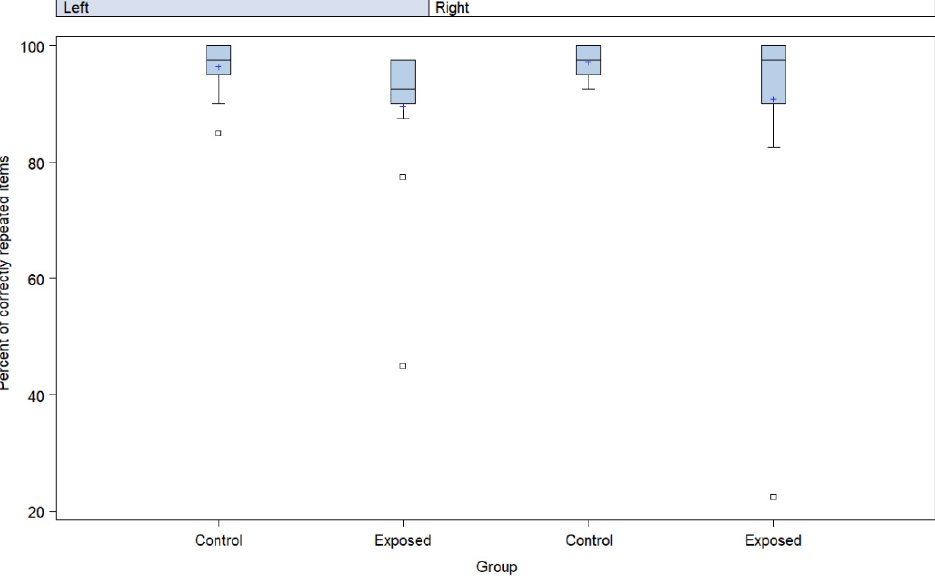
Figure 5. Boxplots of the scores (in percentage) obtained in the dichotic digits test (binaural integra- tion) by exposure group.